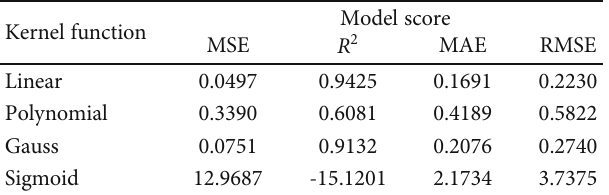
Figure 2: The fi gure of SVM. Table 6: SVR+PCA model score.